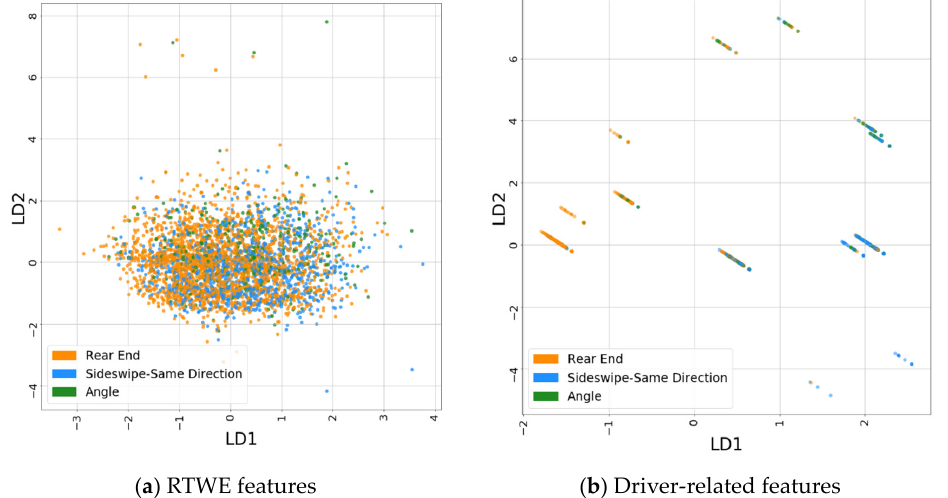
Figure 6. Projection of crash data in the two Linear Discriminant Analysis (LDA) axes; (a) results for RTWE feature set, (b) results for driver-related feature set. Table 5. Loading factors for RTWE